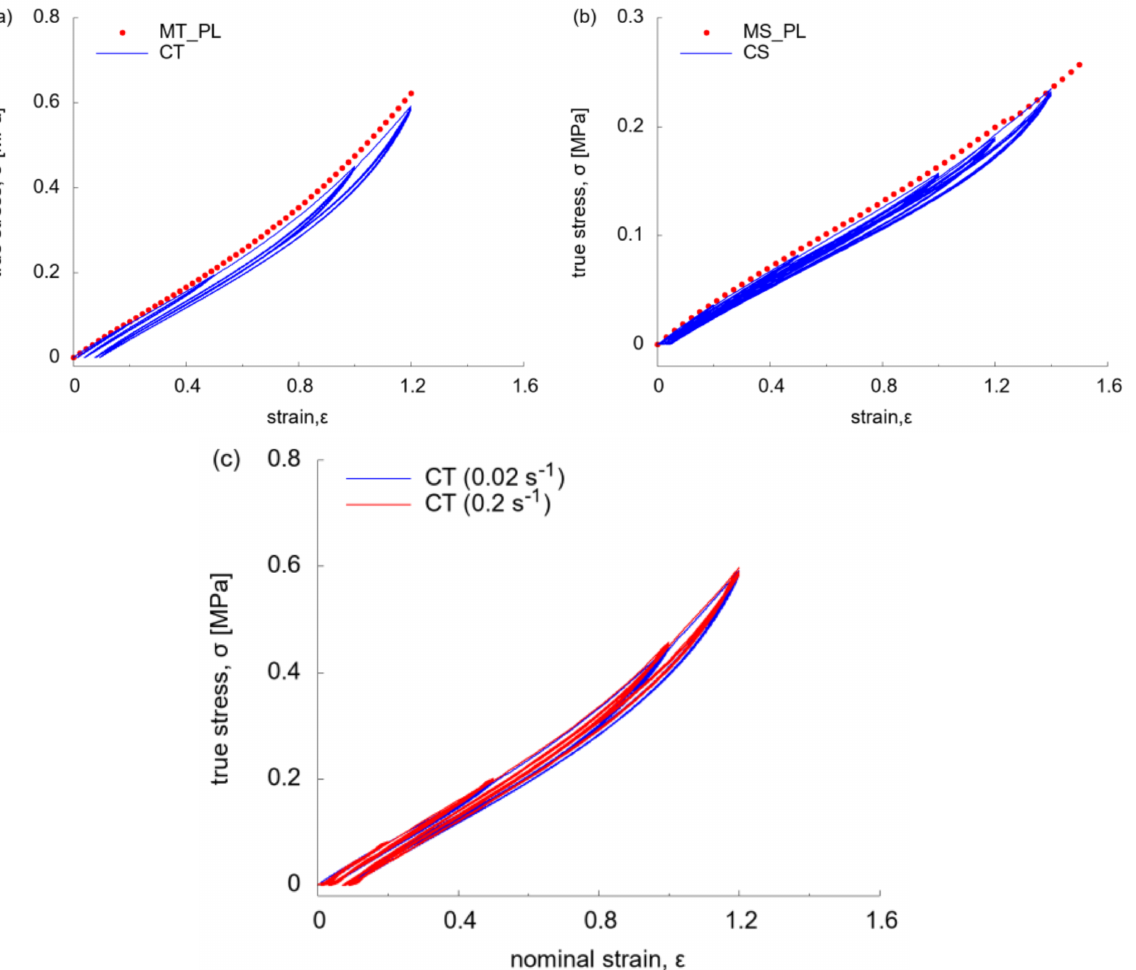
Figure 7. Stress-strain relationship under cyclic test: ( a ) at uniaxial tension (0.02 s − 1 ); ( b ) at simple shear (0.02 s − 1 ); ( c ) at uniaxial tension (0.02 s − 1 vs. 0.2 s − 1 ).